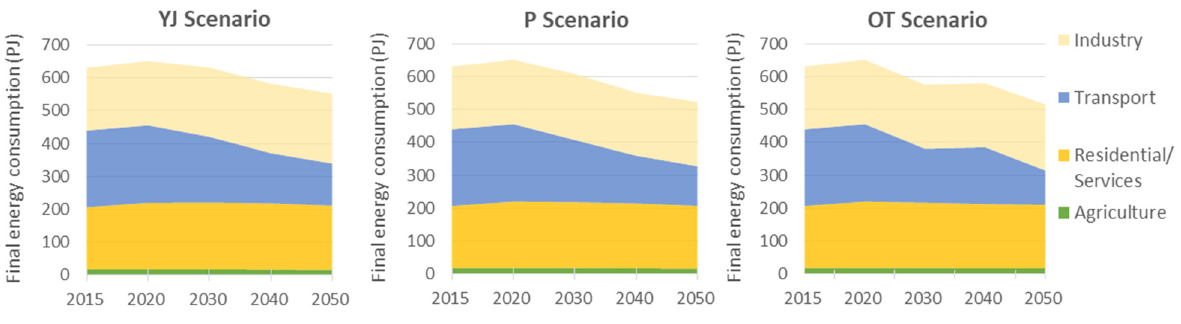
Figure 5. Final energy consumption (PJ) by sector and scenario: (YJ) Yellow Jersey; (P) Pack; and (OT) Off Track.